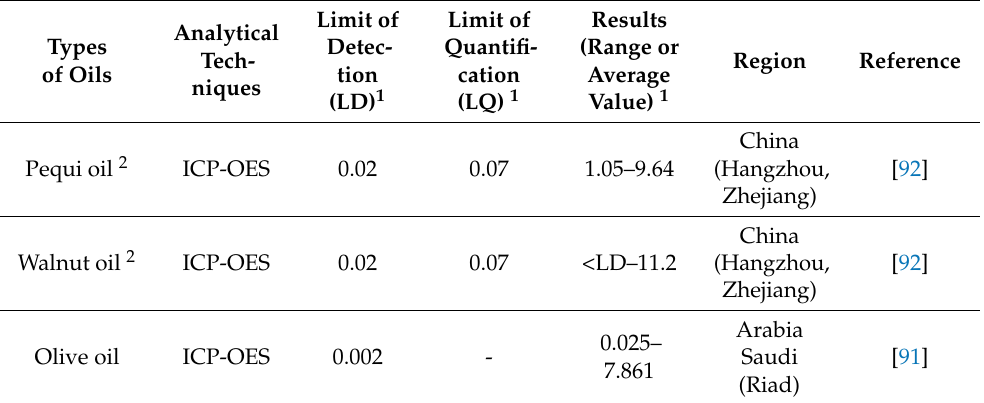
Table 6. Results obtained from the presence of iron (Fe) in edible vegetable oils, expressed in